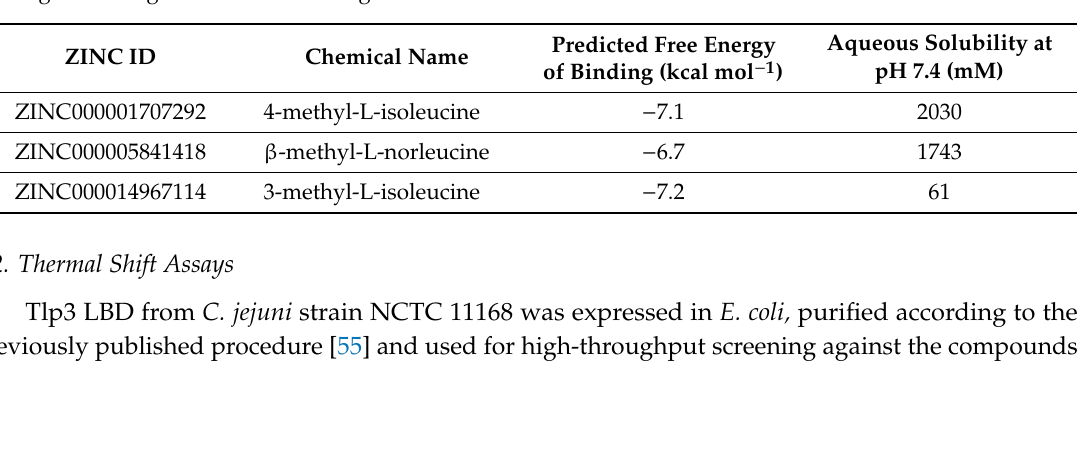
Table 1. The top three L-isoleucine analogues identified as potential Tlp3 ligand-binding domain (LBD) ligands using an in silico